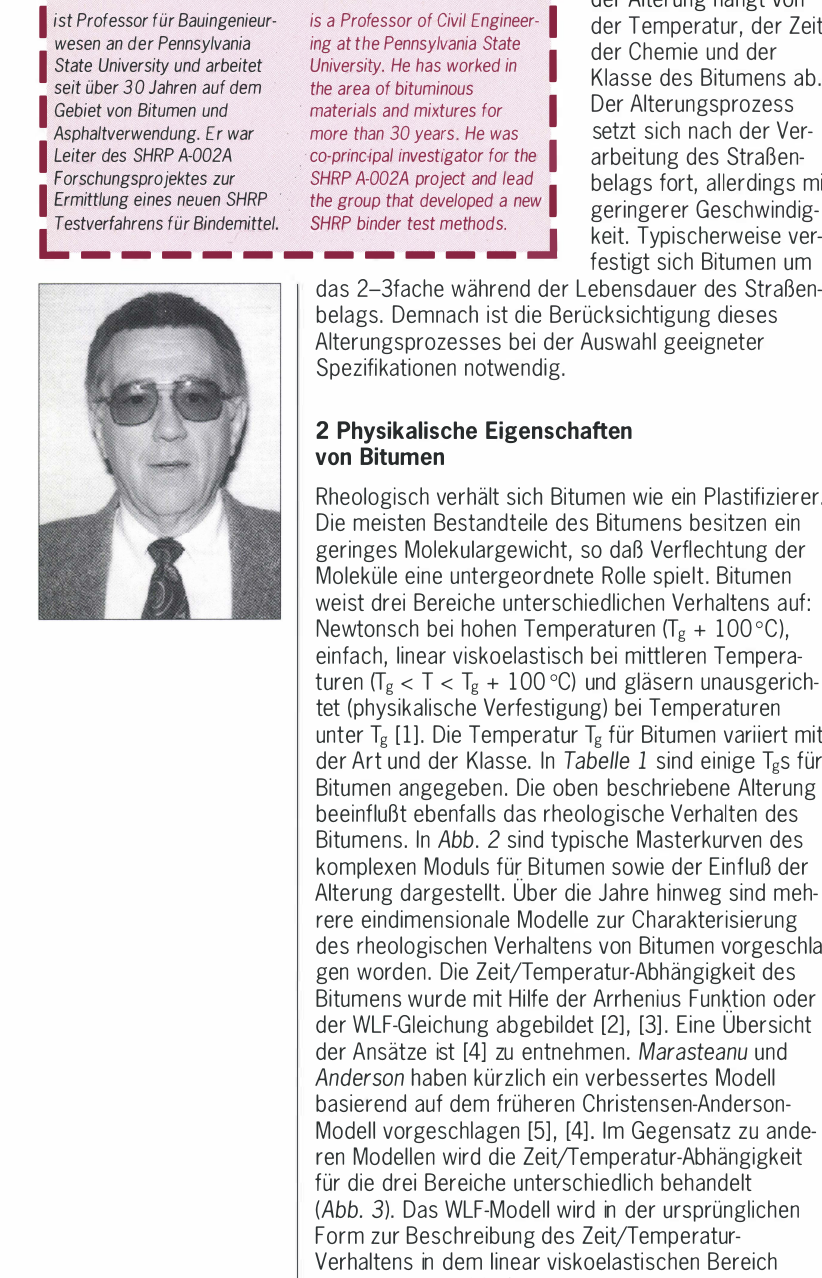
Tabe/le 1: Glasiibergangstemperaturen fiir SHRP-Bitumen (PAV gealtert] [1] Table 1: Glass Transition Temperatures for SHRP Core Bitumen (PAV Aged] [1]